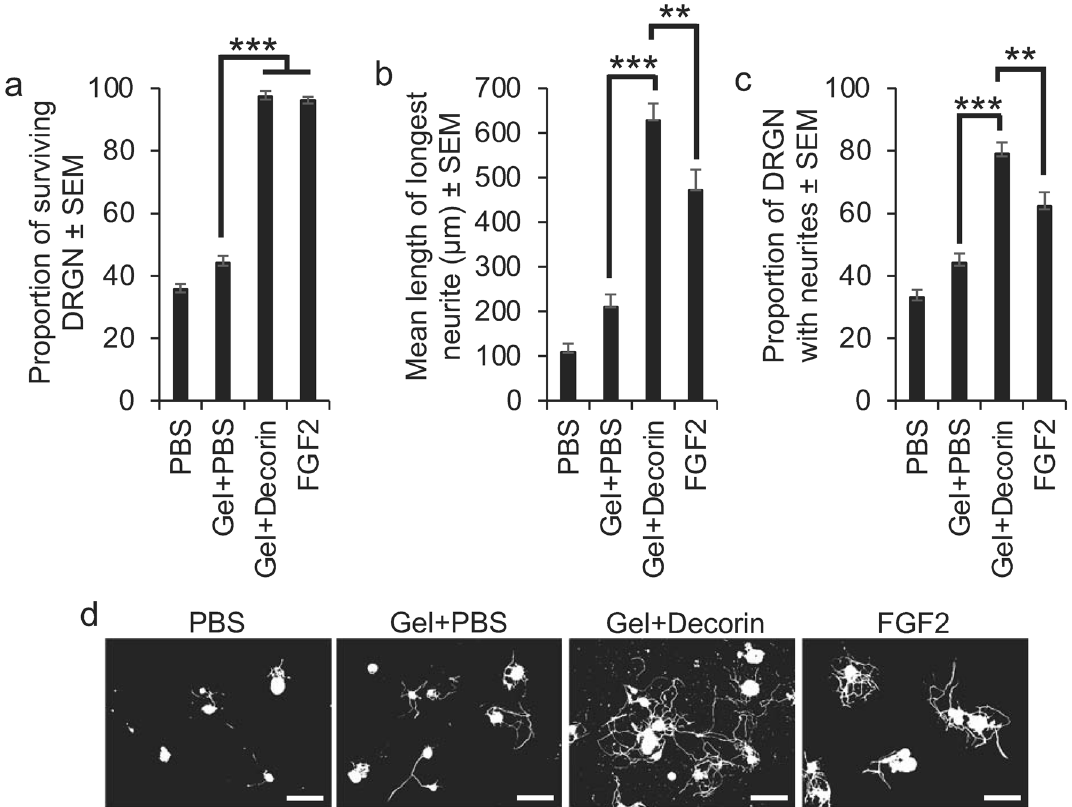
Figure 2. Gel + Decorin promotes DRGN survival and neurite outgrowth in vitro in a serum-withdrawal model. ( a ) Gel + Decorin increased the proportion of surviving DRGN, which was similar to that observed with the positive control, fibroblast growth factor-2 (FGF2). Gel + Decorin treatment also increased ( b ) the mean DRGN neurite length and ( c ) the proportion of DRGN with neurites. ( d ) Representative photomicrographs to show neurite outgrowth after PBS, Gel + PBS, Gel + Decorin and FGF2 treatment. Scale bars in ( d ) = 100 µm. ** P < 0.001; *** P < 0.0001, one-way ANOVA with Dunnett’s post hoc test. n = 3 wells/condition, 3 independent repeats, total n = 9